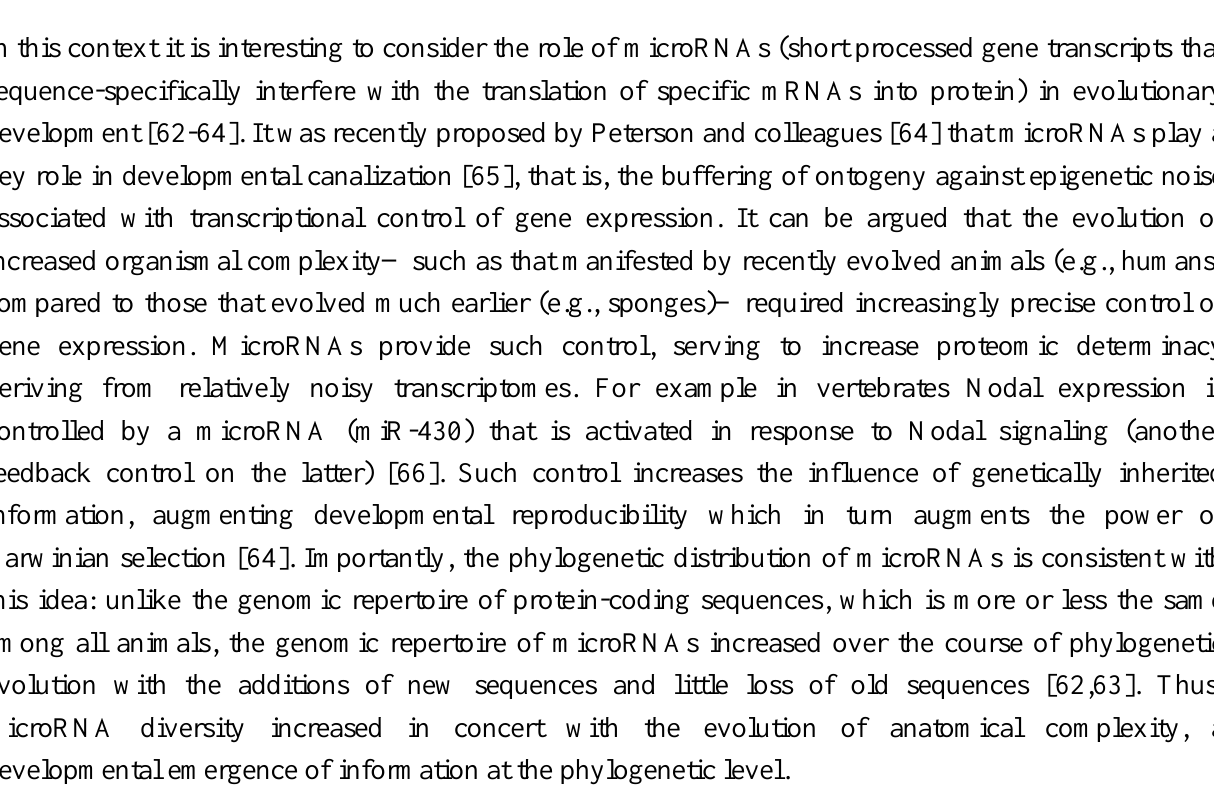
Figure 4. A simplified phylogenetic tree of animals with estimates of the approximate evolutionary divergence times (in millions of years before present